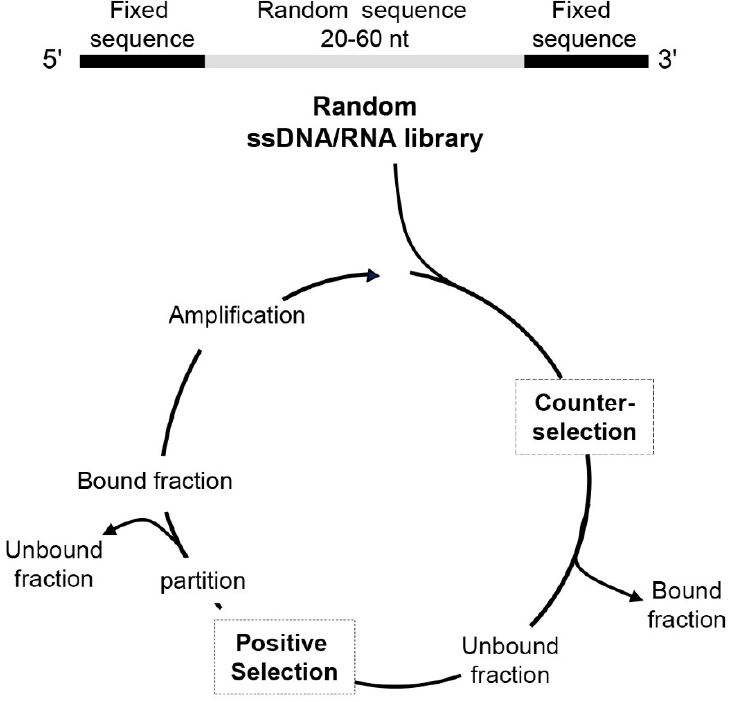
Figure 1. Schematic representation of the Systematic Evolution of Ligands by Exponential Enrichment (SELEX) technology. The starting point is the generation of a library of single-stranded DNA (ssDNA) or RNA that contains a randomized region flanked by two fixed primer-binding sequences on both ends to allow enzymatic amplification and in vitro transcription (in the case of the RNA library). The SELEX method consists of iterative steps of incubation, partition, recovery and amplification (see text for details).